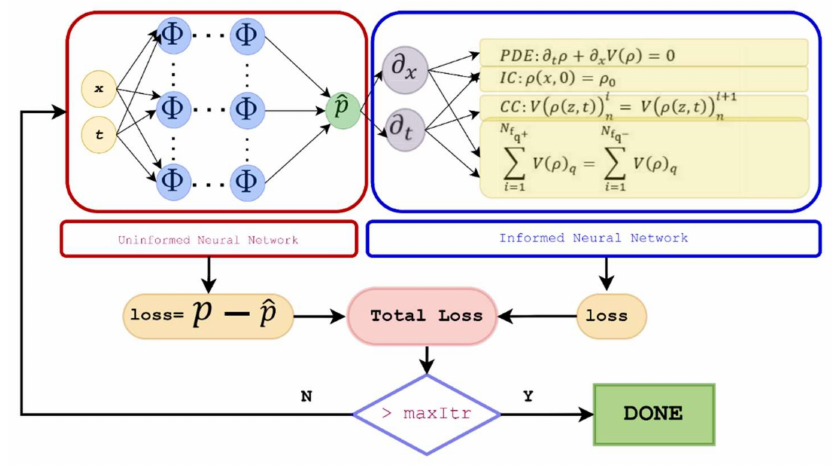
Figure 1. Neural network architecture of the proposed